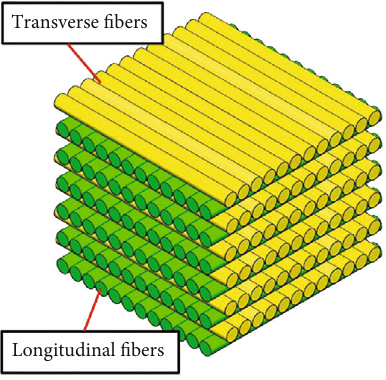
Figure 5: Schematic of weak